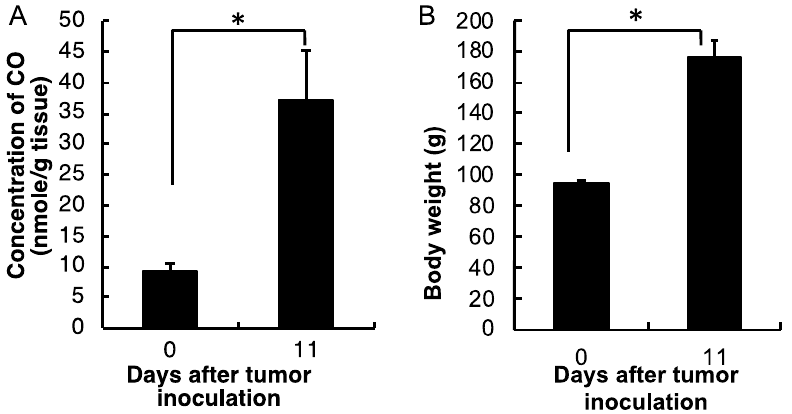
Figure 2. Dynamic changes in CO concentrations in the blood of the AH136B ascitic tumor-bearing rat ( A ), and the tumor growth of AH136B ascitic tumor as described by the body weight changes ( B ). Data are mean ± SEM, n = 4–6. * p < 0.05. See text for details.